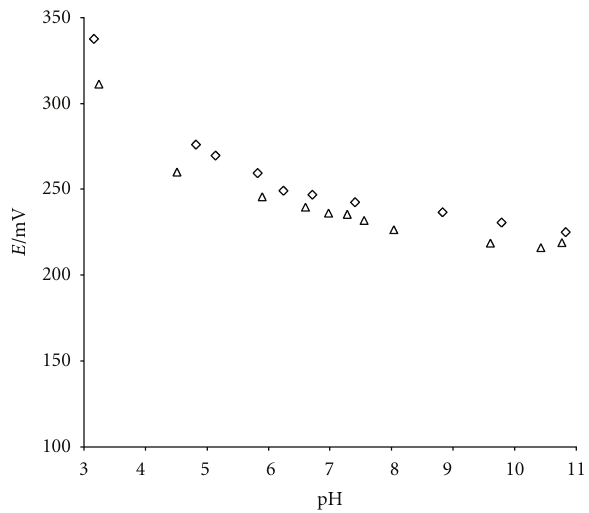
Figure 4: Electrode potential of the nonporous polycrystalline hematite electrode as a function of pH of the solution in the presence of NaClO 4 ( c = 10 − 3 moldm − 3 ). Titrations were per- formed under the ultrasound, using the ultrasound probe (220W). Titration of acidic solution with NaOH ( ♦ ) and back titration of basic solution with HClO 4 ( (cid:5) ). Temperature: 25.0 ◦ C.